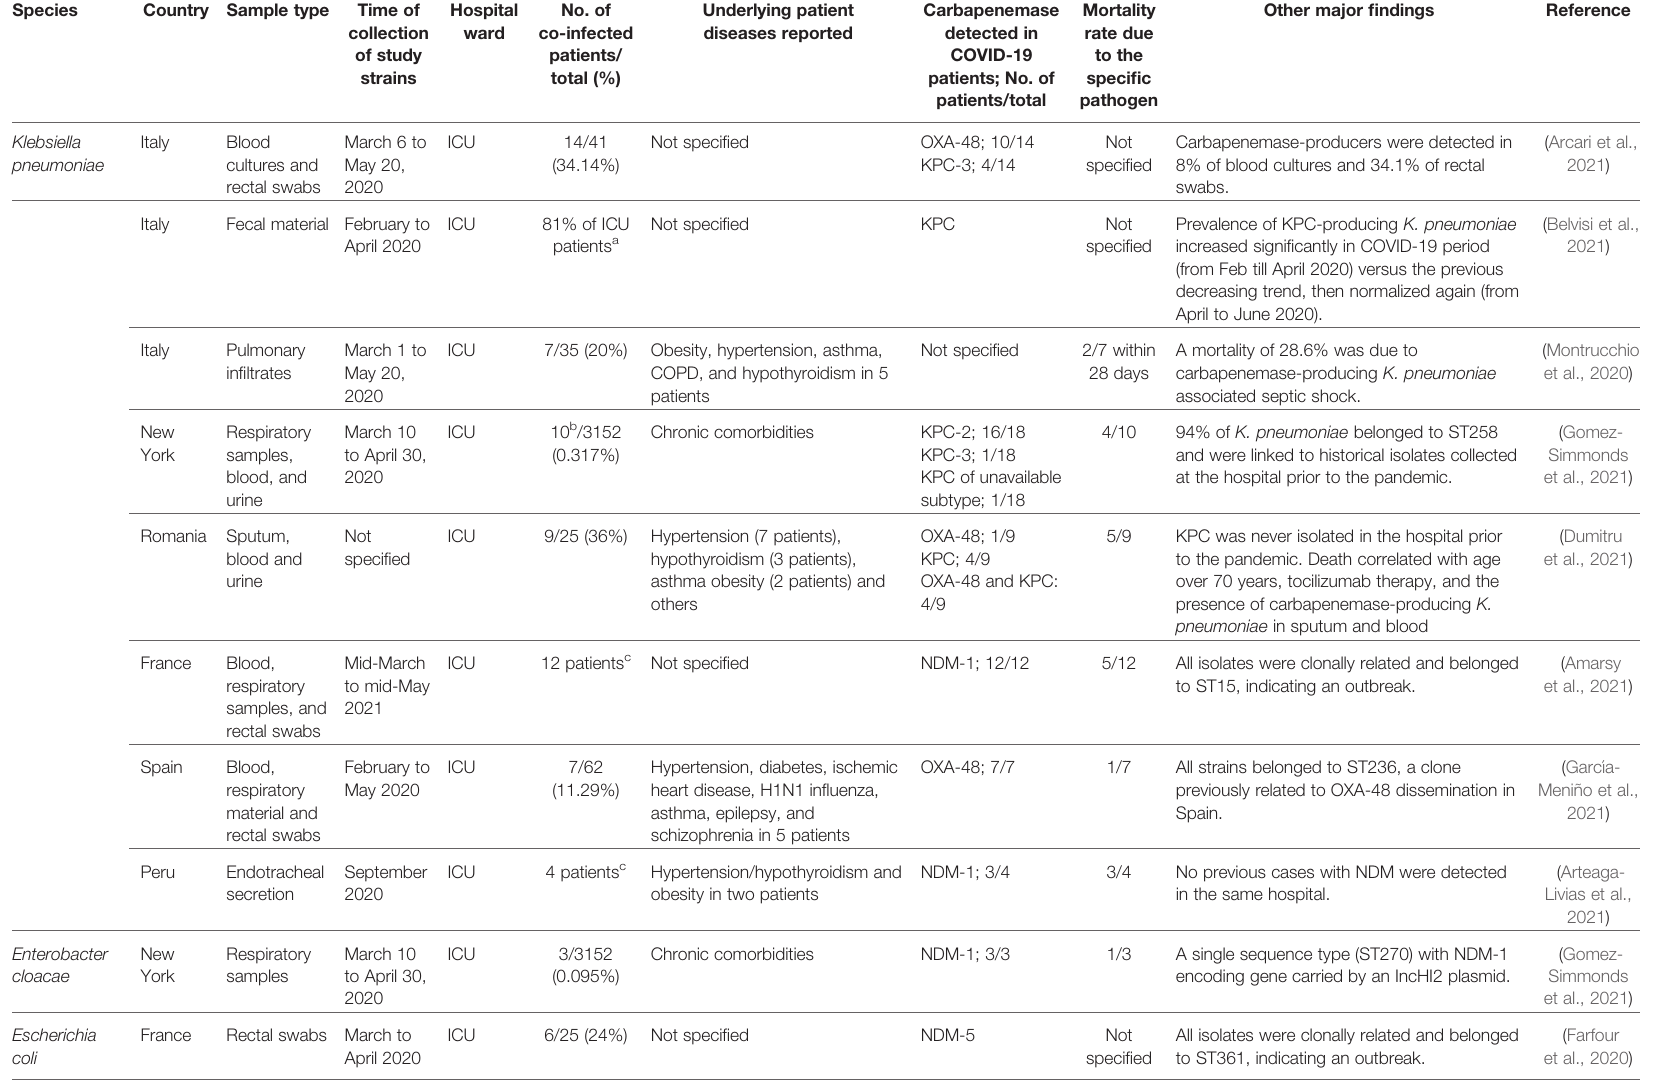
TABLE 1 | Summary of studies describing carbapenemase-producing Gram-negative pathogens reported in COVID-19 patients as of August 2021.